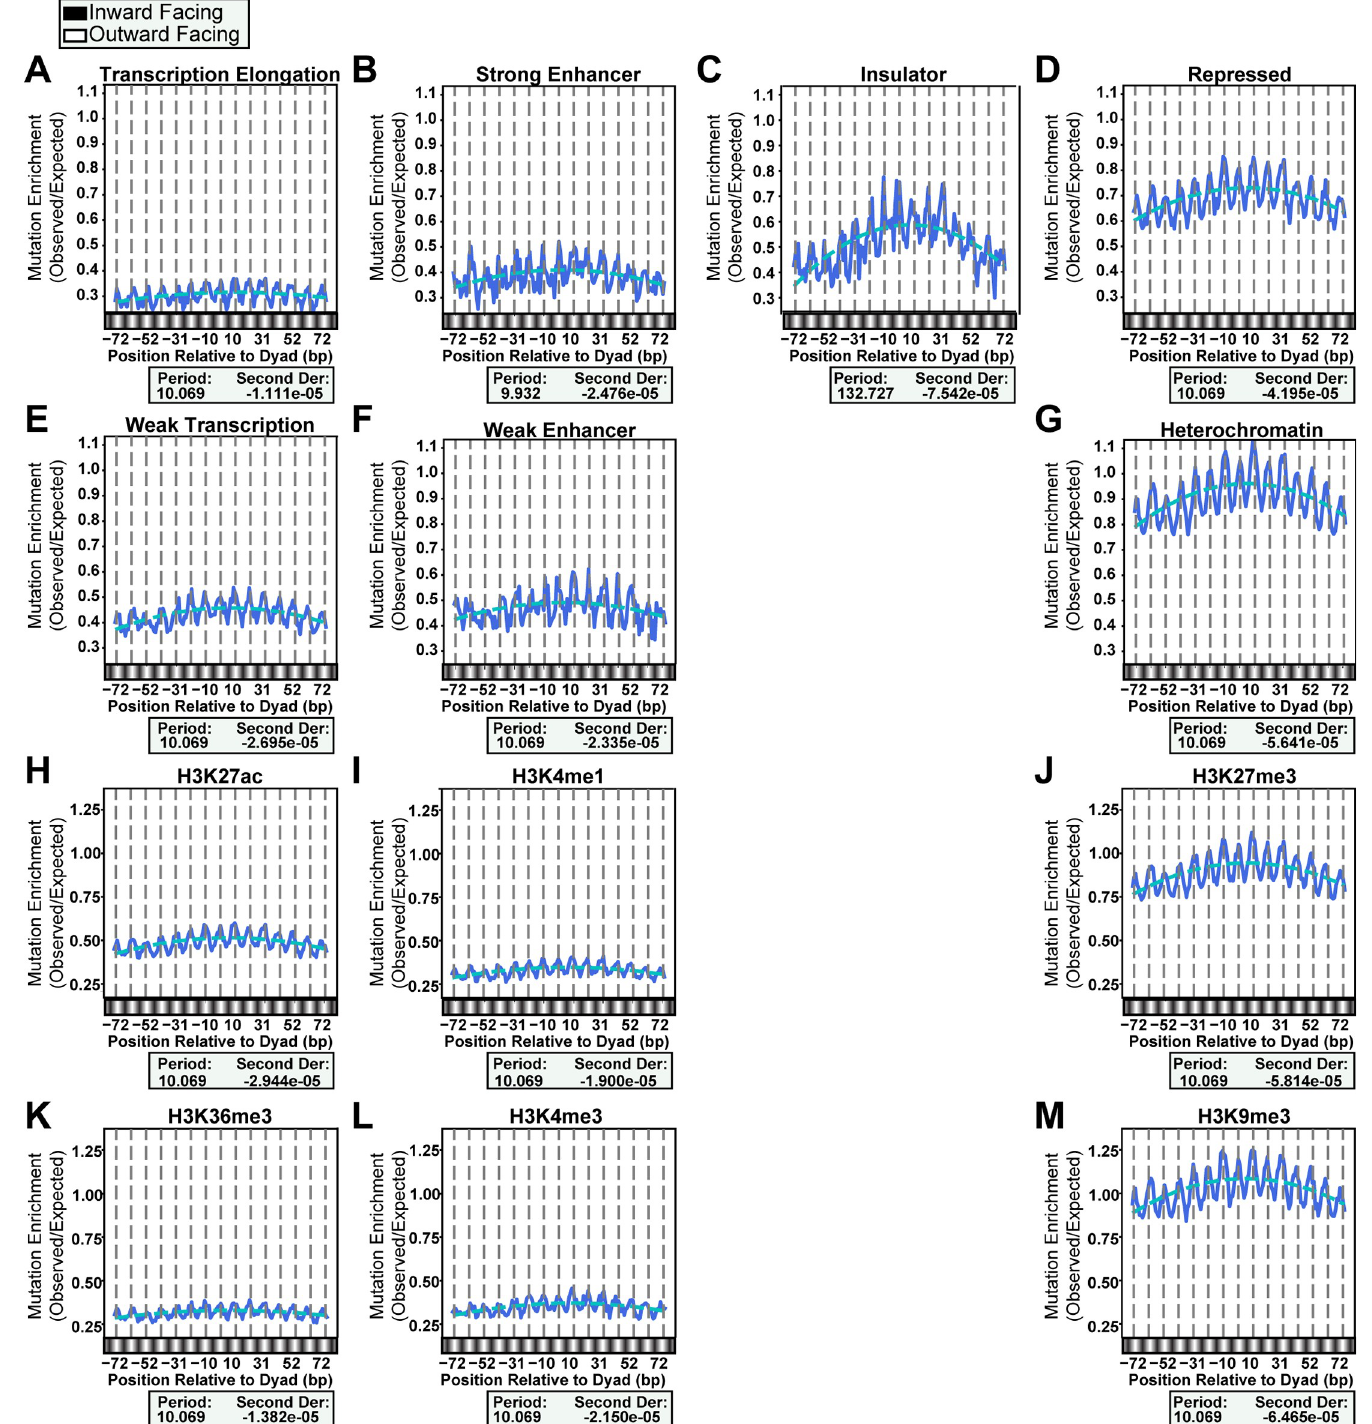
Fig 4. Mutations at nucleosomes parsed by chromatin state and histone modification. Mutations enrichments (solid blue lines) at nucleosomes across multiple chromatin states ( A-G ) and with different pre-existing histone modifications ( H-M ) show the same ~10 bp periodicity. Overall mutation enrichment varied widely across all chromatin states (p-value = 0.0014 by Kruskal-Wallis) and all histone modification-sorted nucleosomes (p-value = 2.55x10-6 by Kruskal-Wallis) with transcription elongation ( A ) and heterochromatin ( G ) and H3K36me3 ( K ) and H3K27me3 ( J ) being some the most different pairs (p-values = 0.0357 and 0.002, respectively by Dunn’s